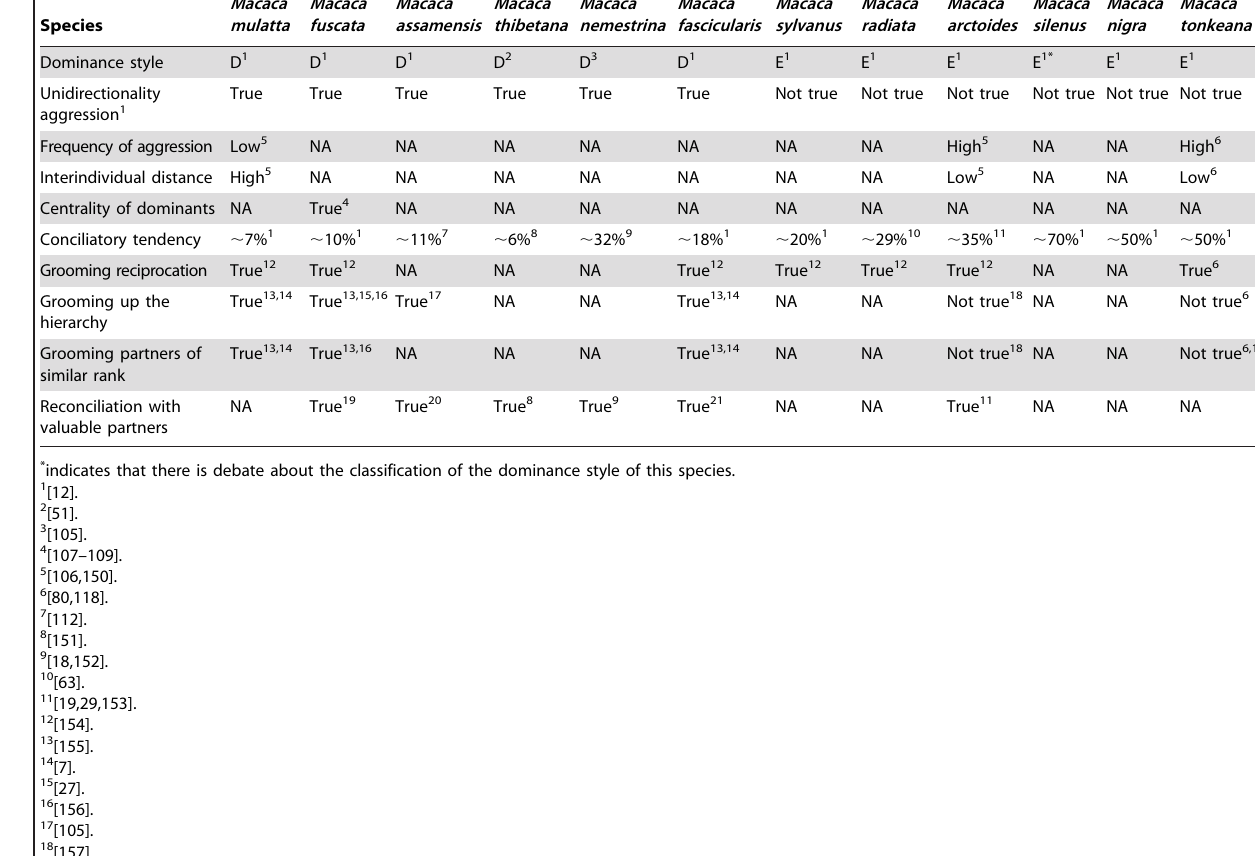
Table 1. Dominance style and affiliative patterns for different species of macaques, D =despotic, E =egalitarian.